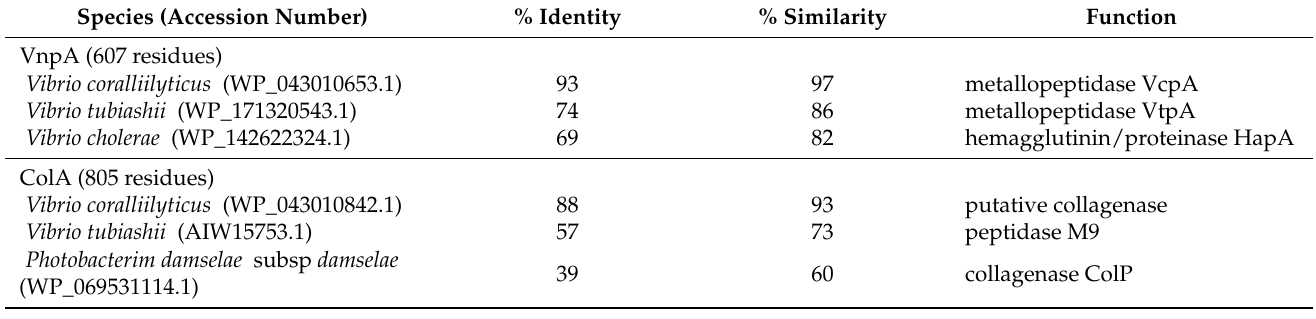
Table 4. Significant homologs of VnpA and ColA.